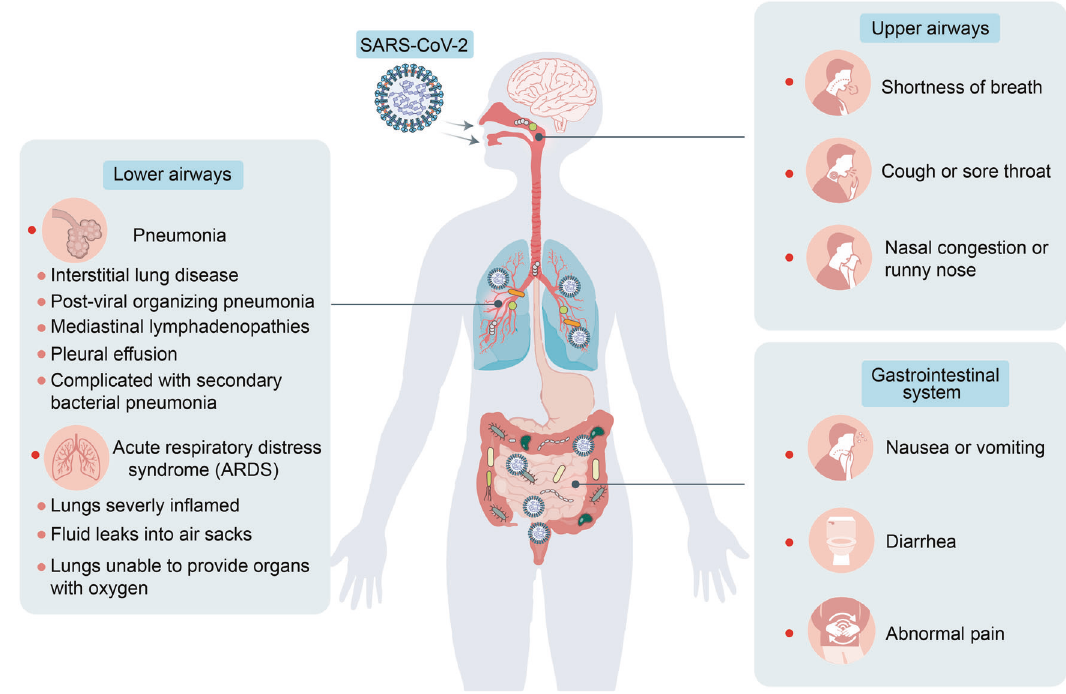
Fig. 1 COVID-19-associated respiratory and gastrointestinal symptoms. Various respiratory and gastrointestinal manifestations occur in patients with COVID-19 including shortness of breath, cough or sore throat, nasal congestion or runny nose, pneumonia, acute respiratory distress syndrome (ARDS), nausea or vomiting, diarrhea, and abdominal